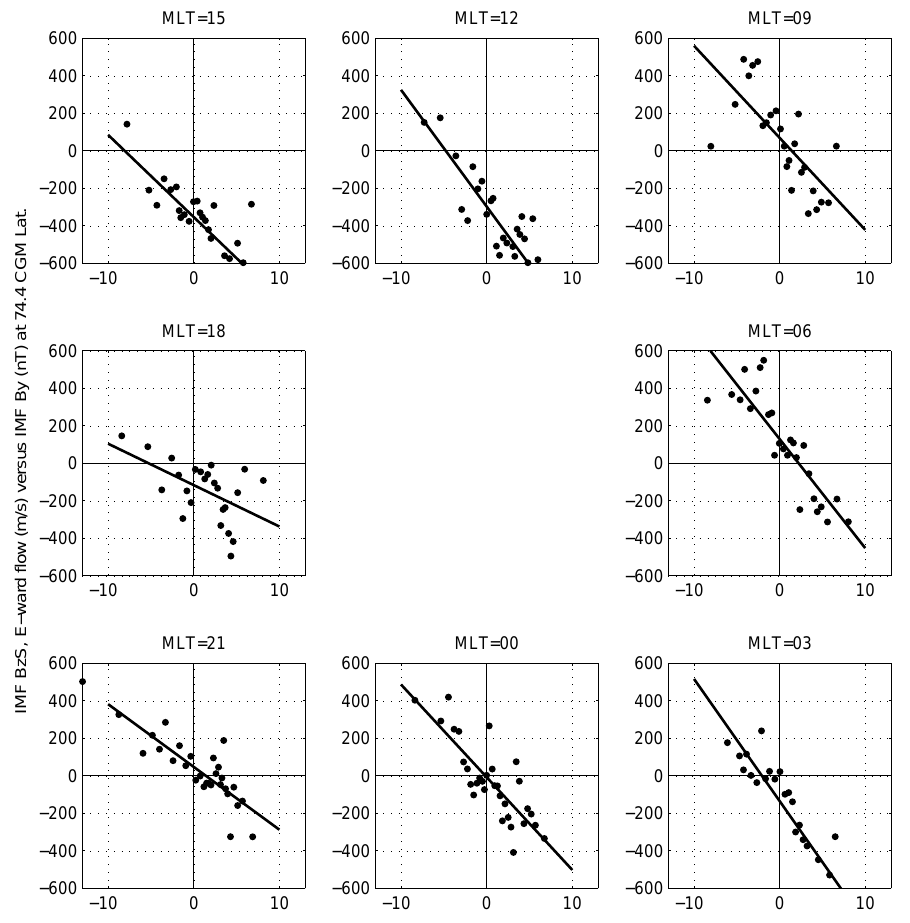
Fig. 2. Dependence of the eastward plasma flow ( V E ) on the IMF B y in the eight 3-h MLT sectors for the IMF B z < 0. sector there are only two data points with positive (eastward) flow. This depicts the overall prevalence of the dusk cell that adds more westward flow near the polar cap